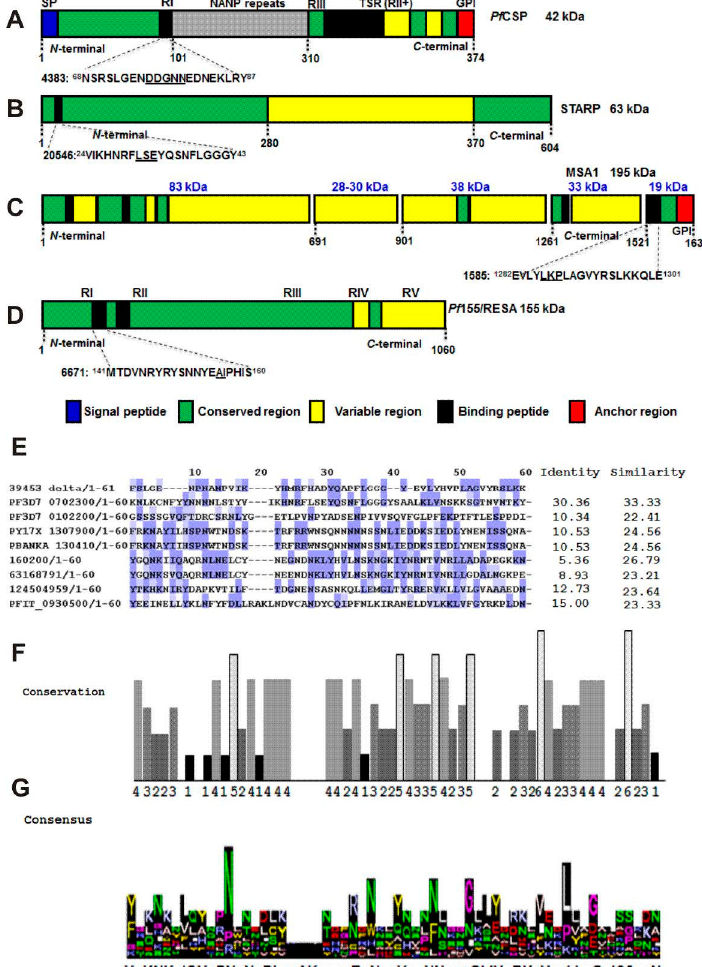
Figure 1. Genetic organization of P. falciparum antigen-peptide targets and bioinformatics. ( A ) Pf CSP sporozoite protein and its 4383 peptide; ( B ) STARP sporozoite antigen and its native 20546 peptide; ( C ) MSA1 merozoite protein and its 1585 native peptide; ( D ) Pf RESA merozoite antigen and its 6671 native peptide; ( E ) Alignment of the large-chimera edited sequence displaying only the Plasmodium -derived sequences (39453_delta chimera). Color code for sequence identify: 80% mild blue; conservation by Jalview-EBI where the 11* score represents identical, 8 and 7 conserved, and 6 and 5 semi-conserved amino-acids respectively; ( G ) A logo-fashion for a consensus sequence is shown in different colors for